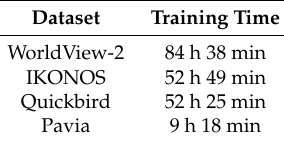
Table 1. Average training time on four datasets (5 × 10 5 iterations).